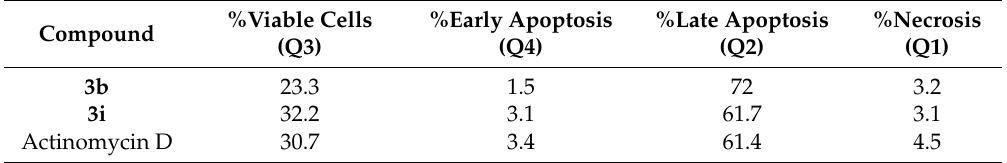
Figure 4. Annexin V–Cy3 SYTOX staining of MCF-7 cells treated with 3b , 3i , and actinomycin D at 1 μ M concentration for 48 h, respectively. Table 3. Percentages of viable, apoptotic and necrotic cells.